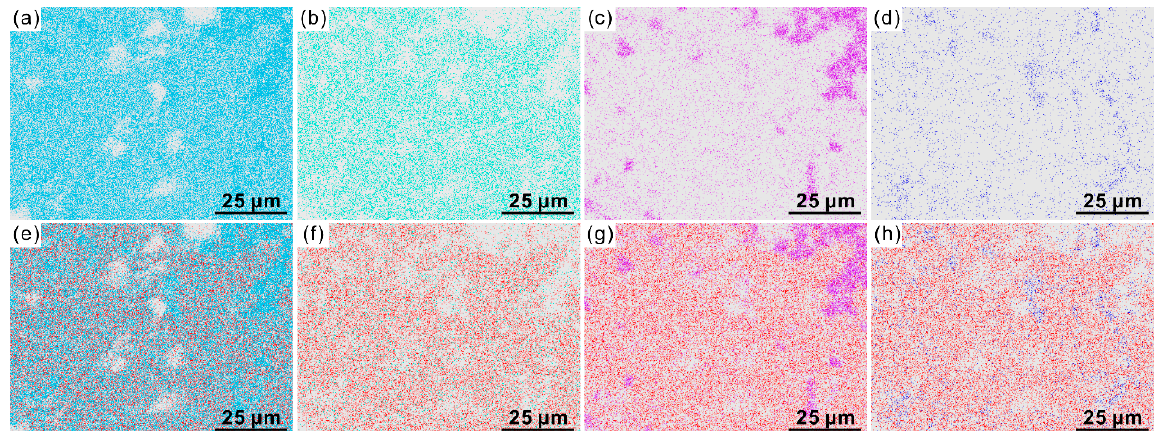
Figure 3. ( a – d ) The element distributions of Ca ( a ), S ( b ), Si ( c ), Fe ( d ), and ( e – h ) overlaps of Pb with the above four elements in SAC clinker samples.